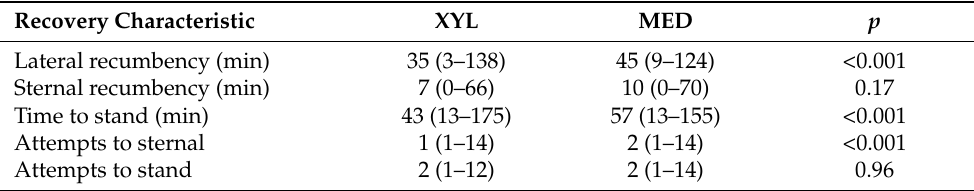
Table 4. Time spent in lateral and sternal recumbency, time to stand, number of attempts to sternal position, and number of attempts to stand following general anaesthesia with isoflurane partial intravenous anaesthesia using either xylazine (XYL, n = 191) or medetomidine (MED, n = 279). Results are presented as median